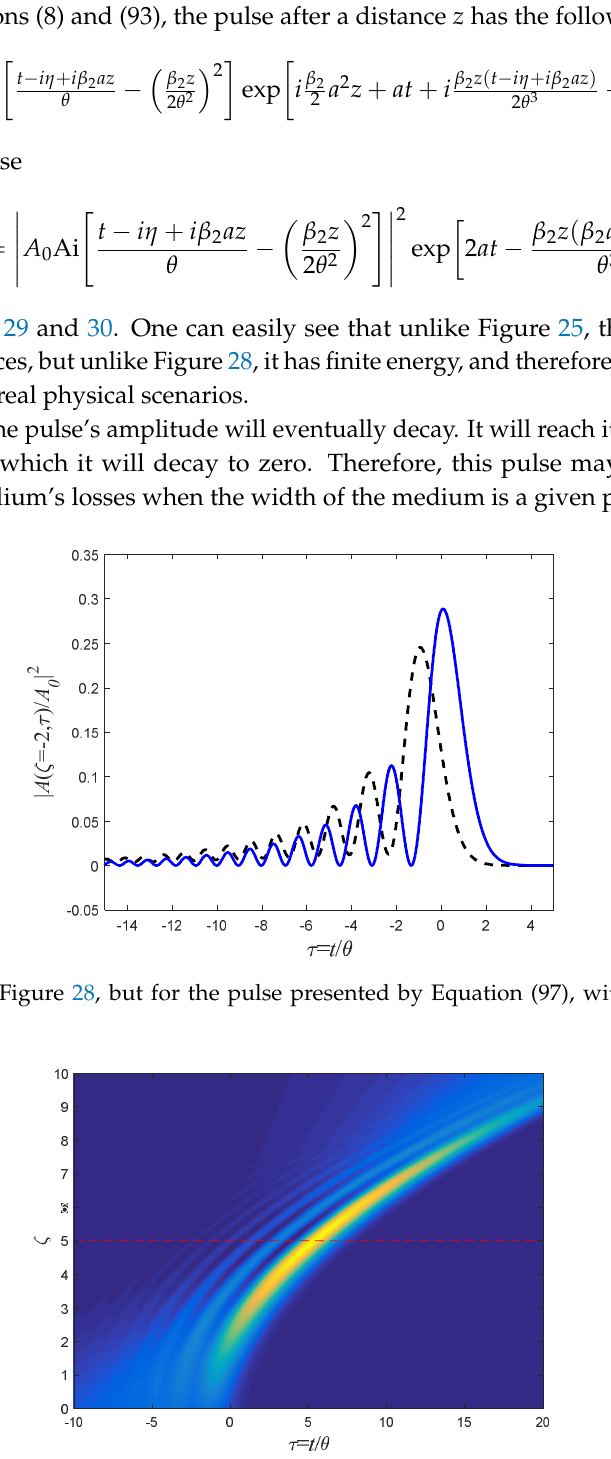
2 , ztA ) of the pulse presented by Equation (97)